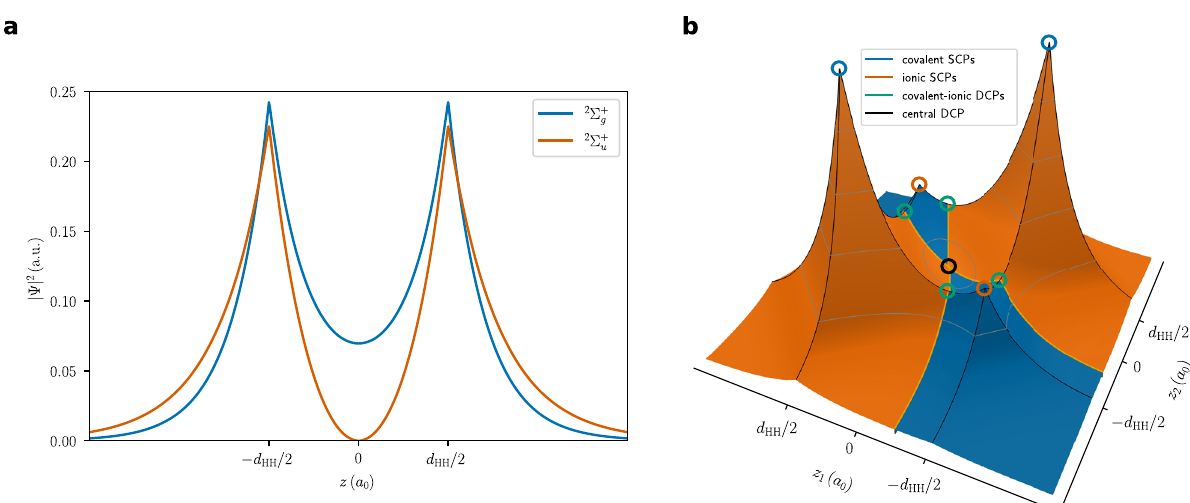
at the equilibrium distance ( d HH = 2.00 a 0 40 ). b H 2 at the equilibrium distance ( d HH = 1.40 a 0 ). 2